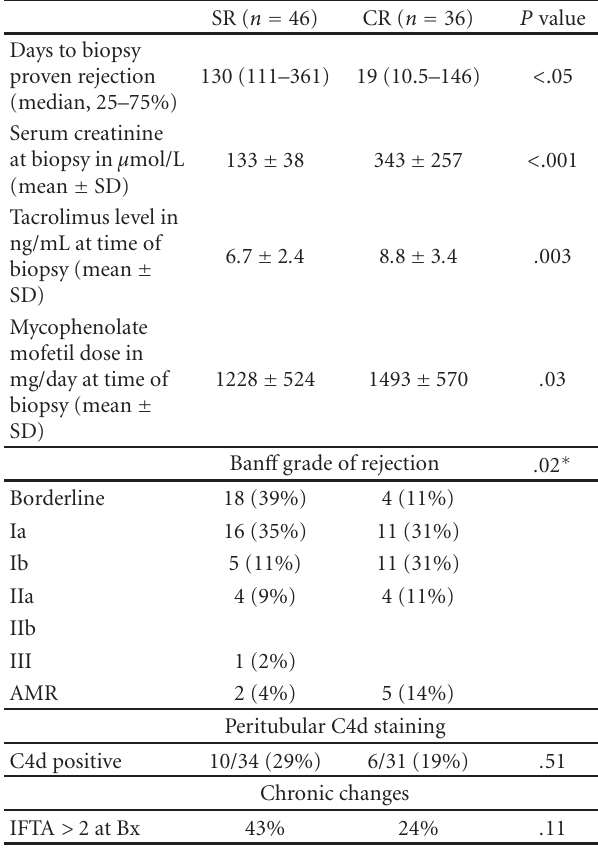
Table 3: Characteristics of Acute rejections. Table 4: Findings on followup 1-year protocol biopsy.